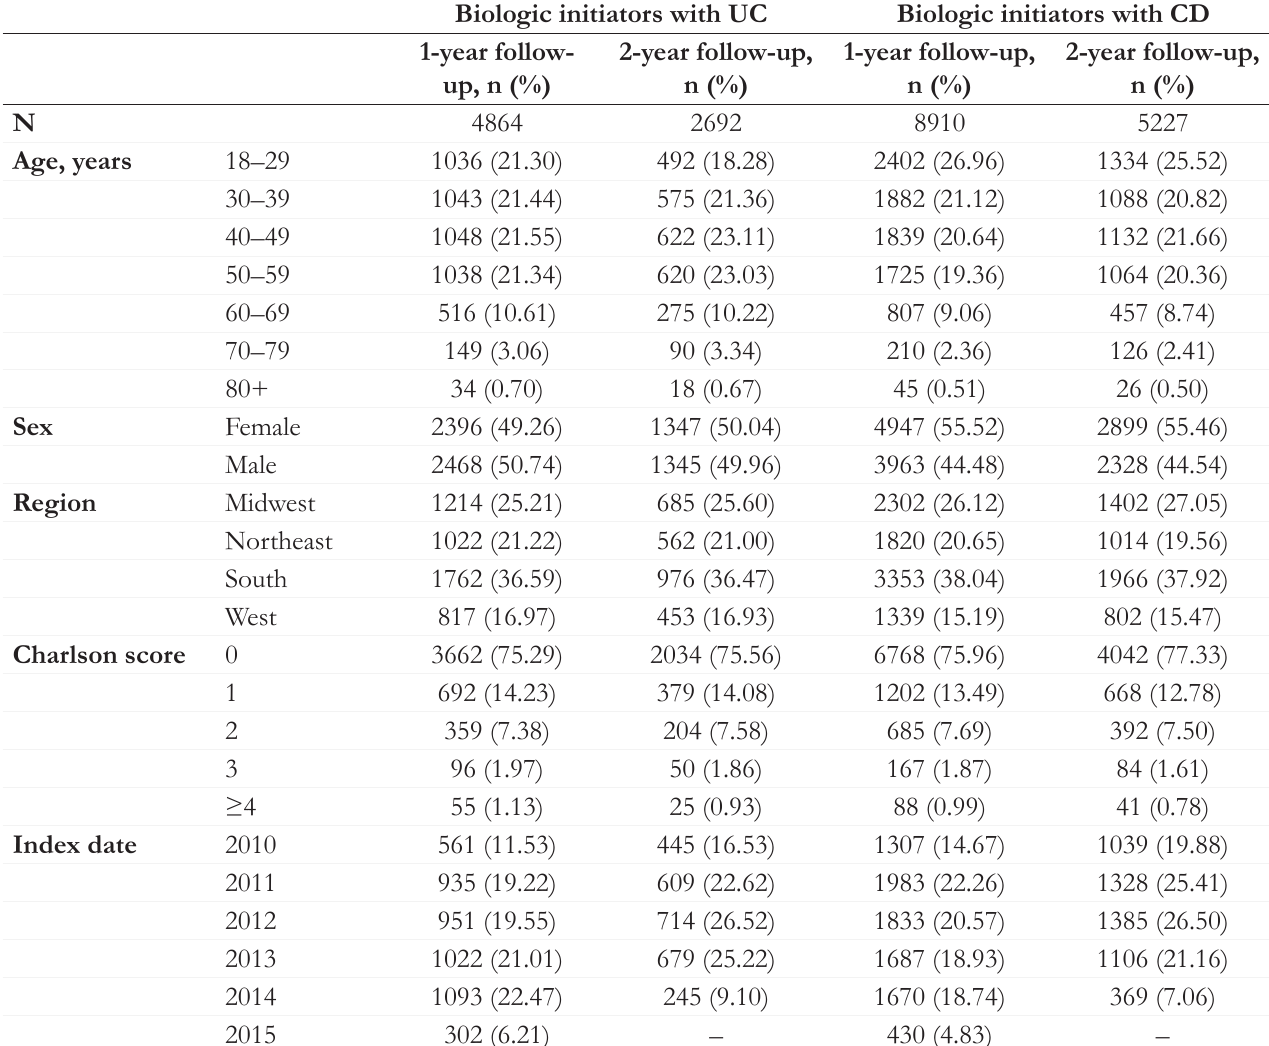
Table 1. Characteristics of Patients with UC or CD Who Initiated Biologics (numbers describe all evaluable patients [ITT], regardless of their continued use of